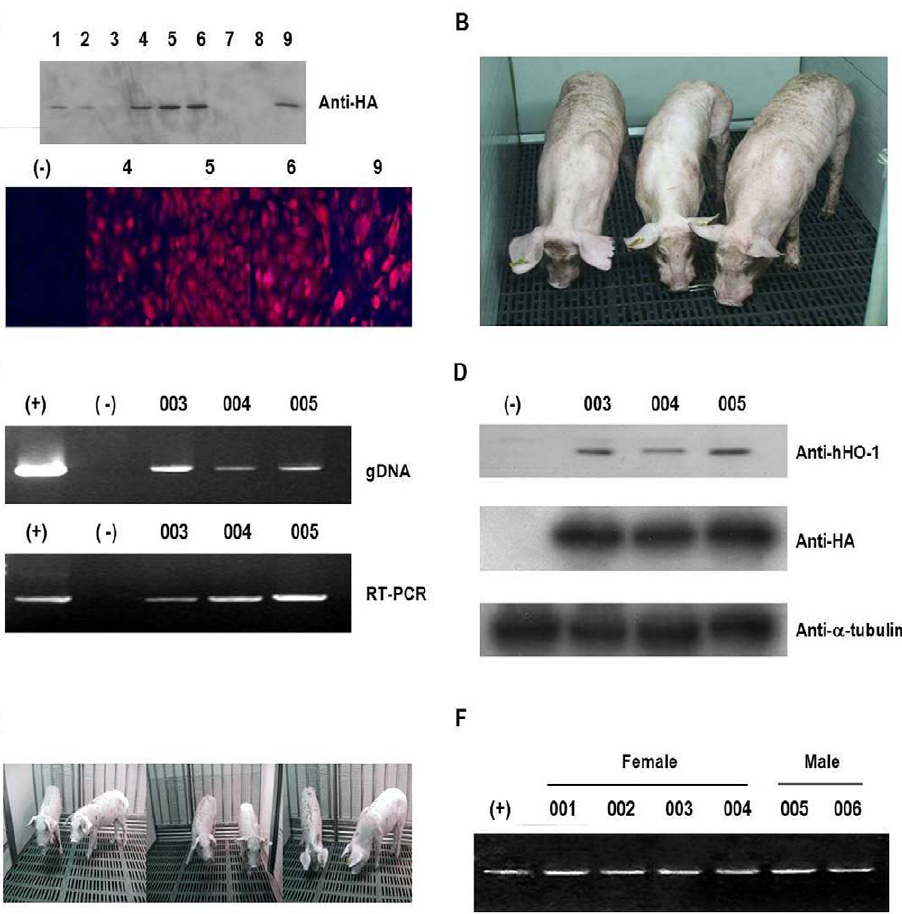
Figure 2. Generation of hHO-1 transfected donor cell lines and hHO-1-Tg pigs. A: Establishment of hHO-1-expressing cells using O-type white Yucatan pig fibroblasts. Expression of hHO-1 was identified by western blot analysis and immunocytochemistry. A donor cell colony with a